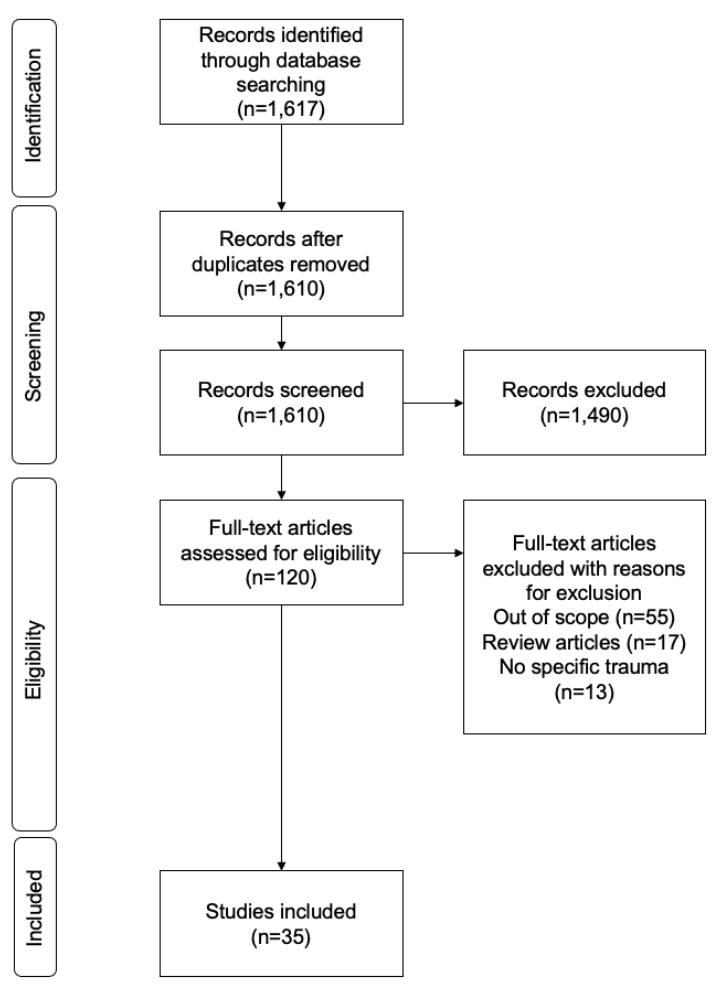
Figure 1. PRISMA flow diagram showing the study selection process.